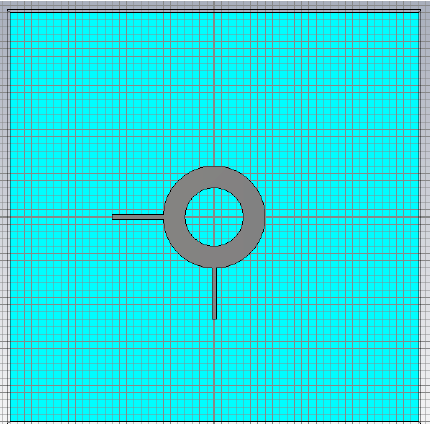
Figure 13: Overview of the microstrip circular resonator. This circular resonator is fed by the via port with the transient current presented in Figure 14. This excitation i ( t ) is assumed as a Gaussian signal modulated 1.25 GHz sine